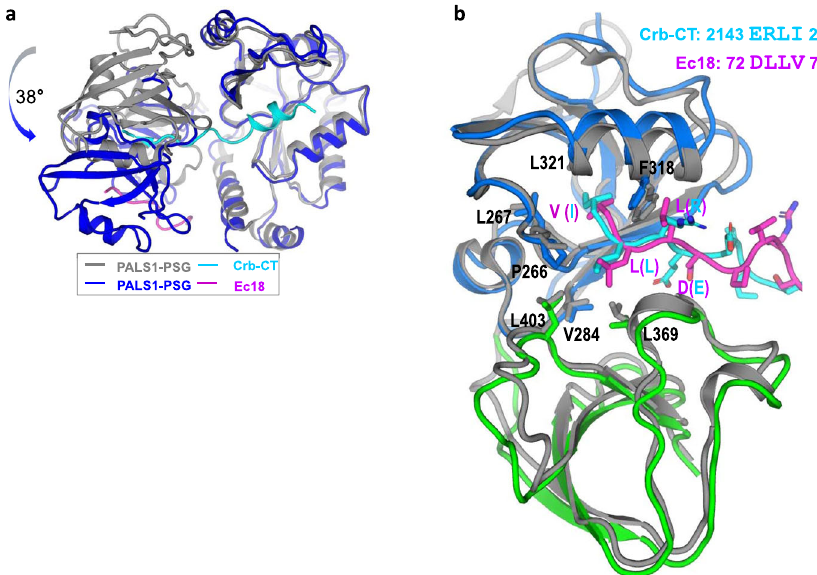
Fig. 3 Structural comparison of PSG – Ec18 with PSG – Crb-CT. a Alignment of the two complex structures based on the GK domain showing a relative rotation of ~38° for the SH3 and PDZ domains. b Structural superposition for the SH3 and PDZ domains showing the binding sites for Ec18 and